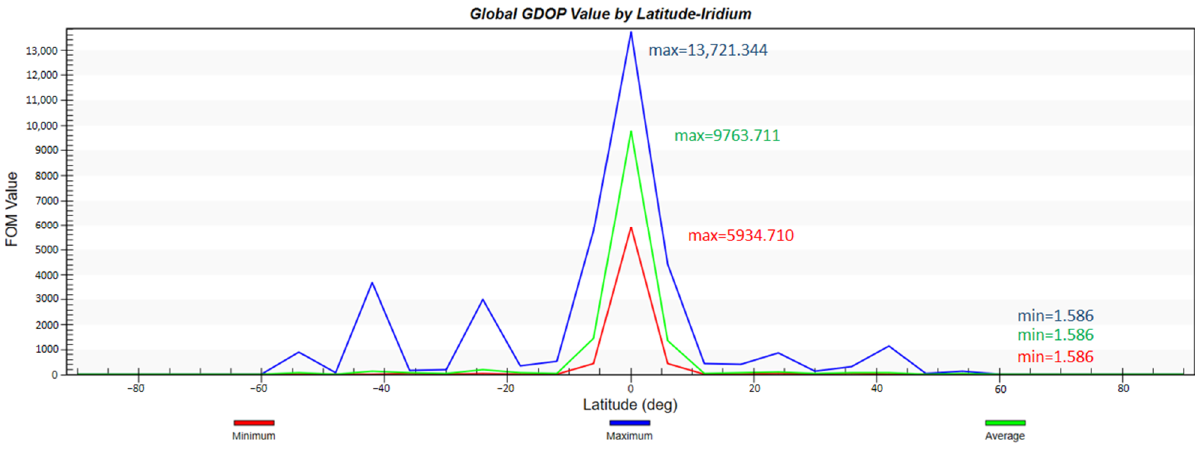
Figure 10. Global GDOP by latitude of Iridium constellation.